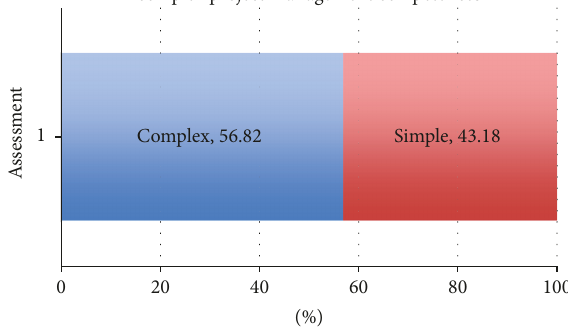
Figure 10: Study case Complexity Index score for